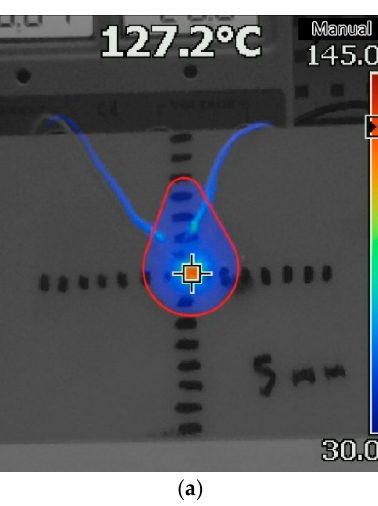
Figure 3. The picture of the heat distribution on the work piece during the experiment; the red contour highlights the heating area in which the temperature was above 303 K : ( a ) wires were laid over the work piece; ( b ) wires were laid under the work piece.